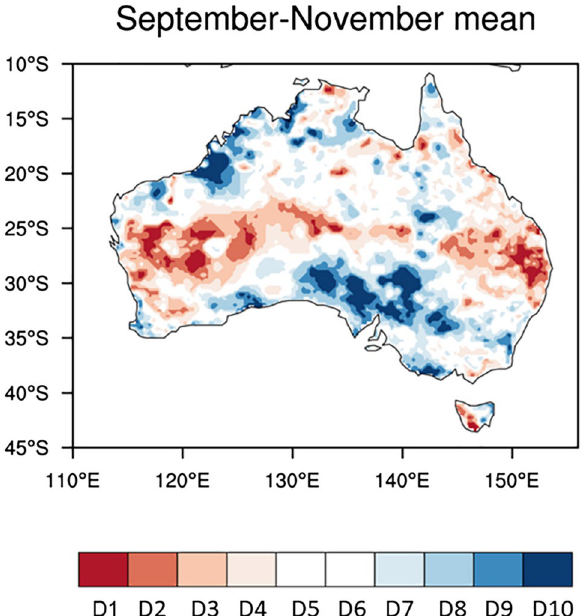
Figure 2. Rainfall decile map of spring 2020. The decile thresholds were obtained from the rainfall data over 1990–2012. A similar decile map but with the thresholds obtained from the full AWAP rainfall record since 1900 is available at http:// www. bom. gov. au/ clima te/ maps/ rainf all/? varia ble= rainf all& map= decil e& period= 3mont h& region= nat& year= 2020& month= 11& day= 30. The map was generated using the NCAR Command Language version 6.6.2 (www. ncl. ucar. edu).